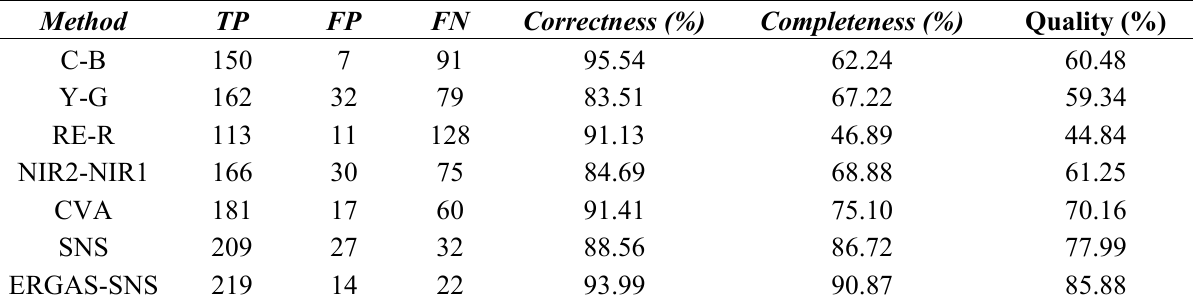
Table 2. Moving vehicle detection results of different